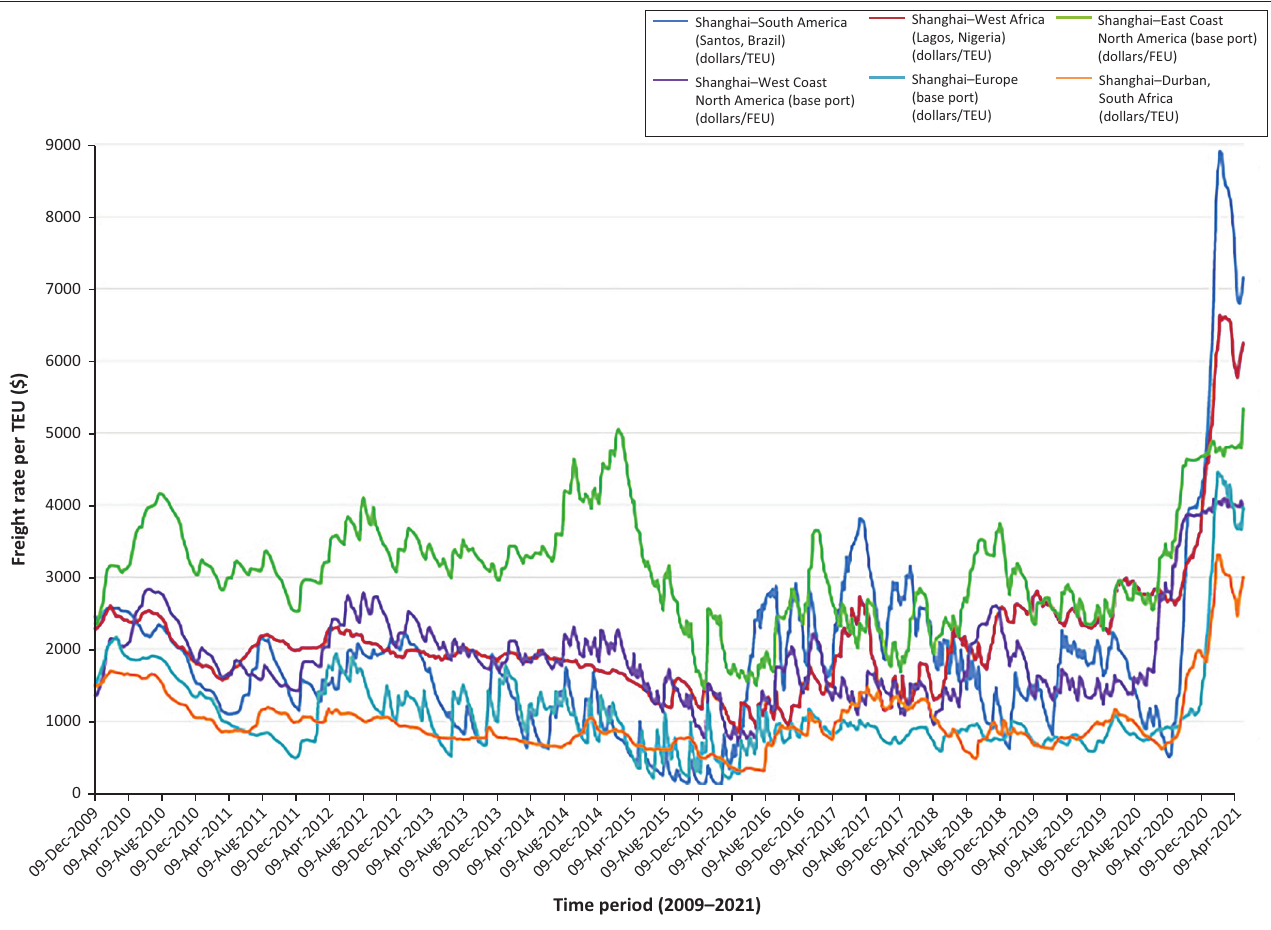
FIGURE 1: Shanghai containerised freight index, weekly spot rates, 18 December 2009 – 09 April